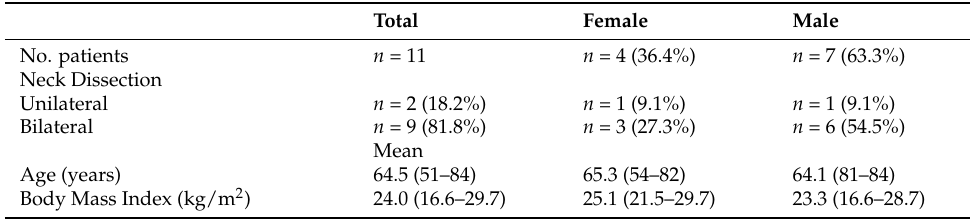
Table 1. Basic data of the study population.